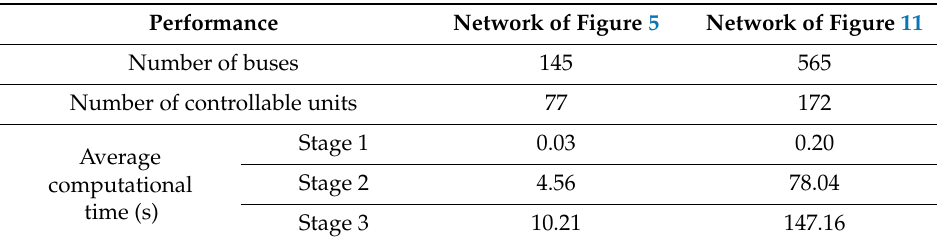
Table 4. Computational performance evaluation by